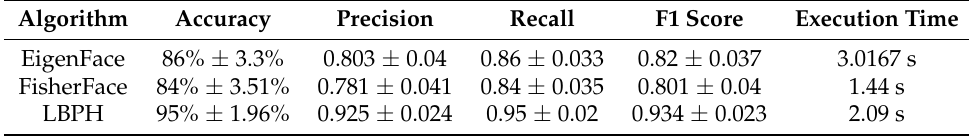
Table 4. Accuracy, precision, recall, F1 score, and execution time on